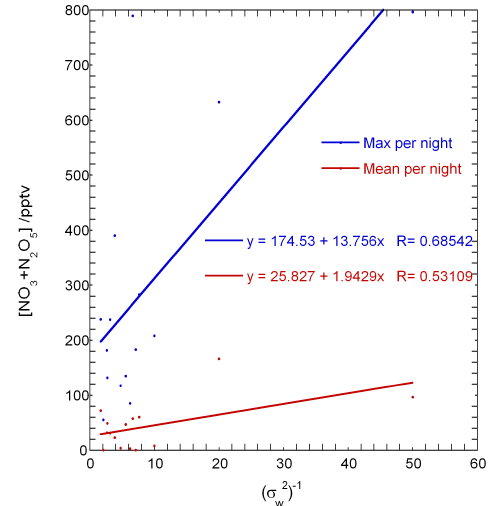
Fig. 9. Correlation plots of the reciprocal of the mean night-time standard variance of the vertical velocity ( σ 2 w ) against maximum (blue) and mean (red) NO 3 +N 2 O 5 mixing ratio per night during REPARTEE-II. Vertical variance data matched onto BBCEAS time- stamp. Night-time as defined by local sunrise/sunset